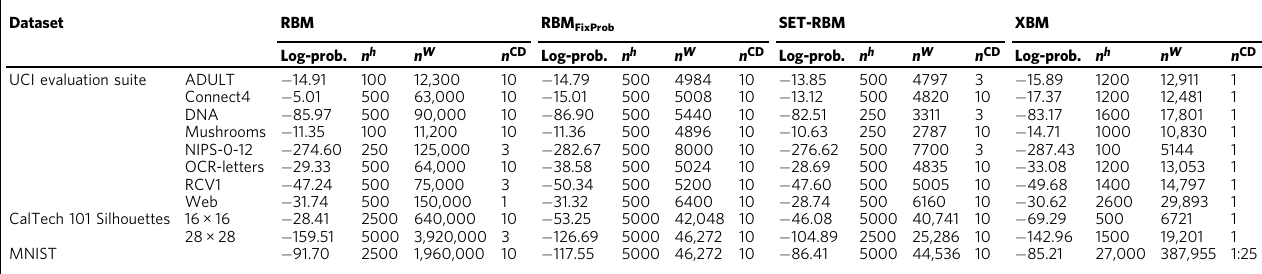
Table 2 Summarization of the experiments with RBM variants Dataset RBM RBM